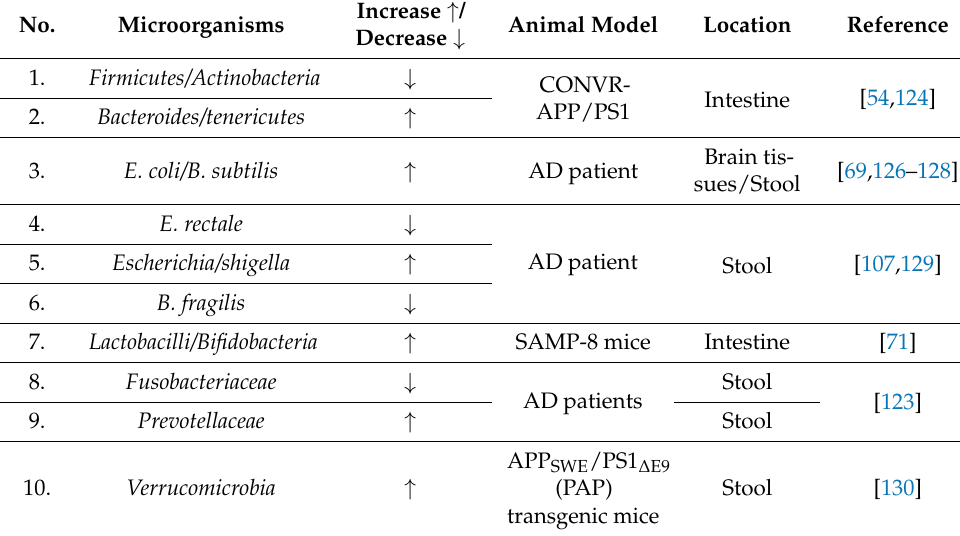
Table 3. Investigation of microbiota in the gut of human as well as animal models of